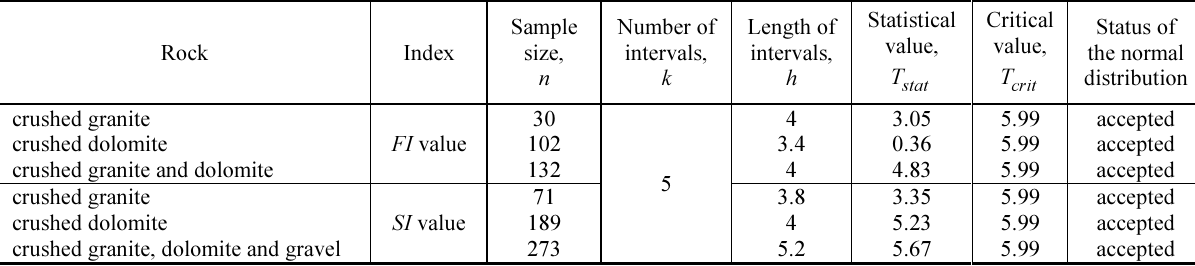
Table 9. Summary of zero hypotheses for proximity between indexes FI and SI of the variance of granite dolomite and gravel Rock crushed granite